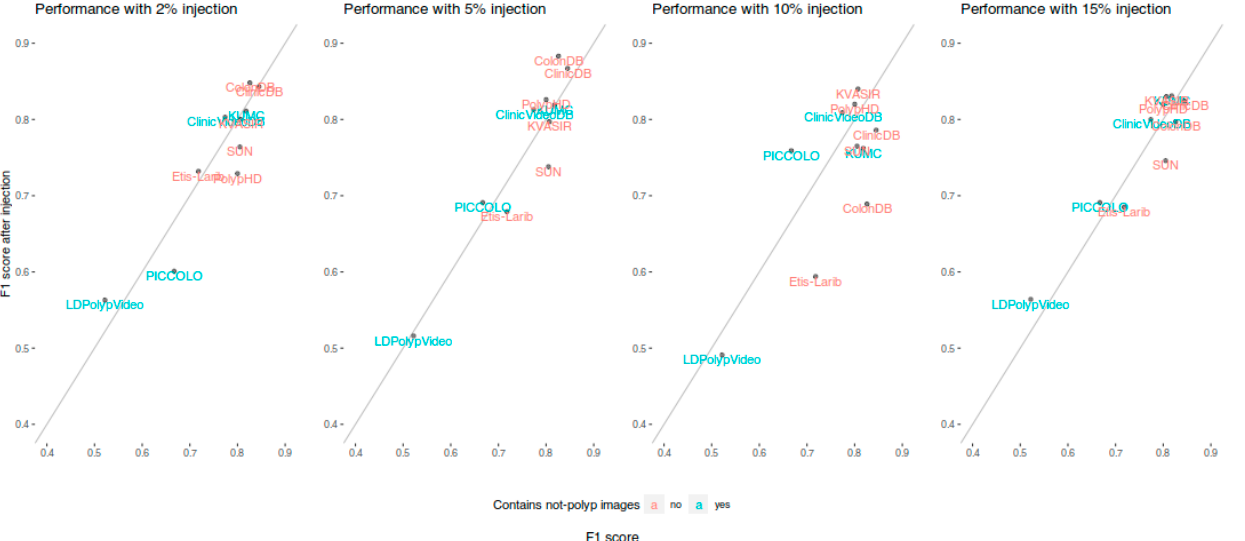
Figure 5. Comparison between the F1 performances obtained by our baseline model in the ten public datasets (X axis) and the F1 performances obtained by the four new models trained with not-polyp images (Y axis). Public datasets containing not-polyp images are marked in light blue. Points above the diagonal line represent benefit.